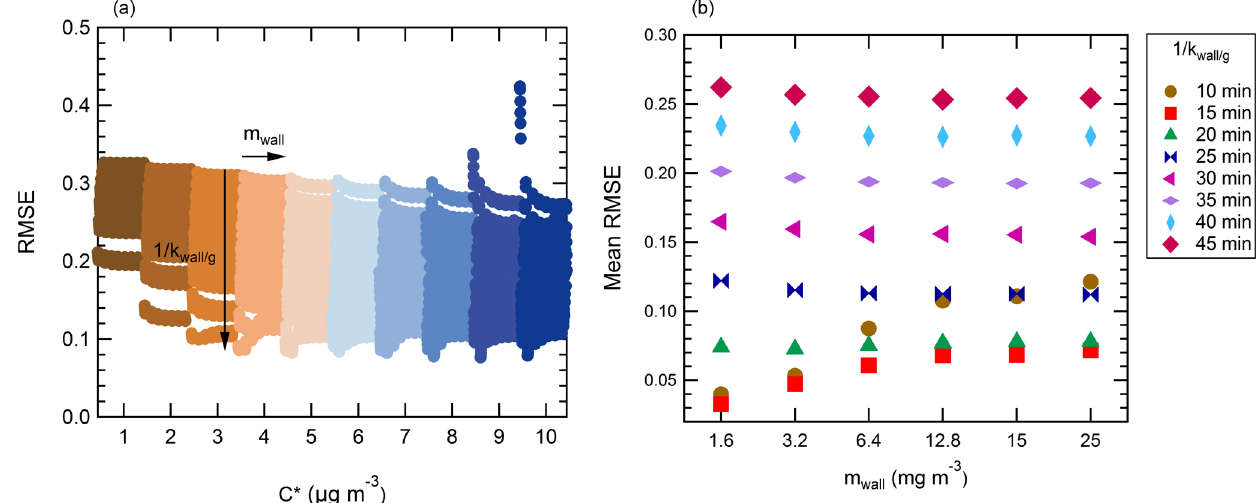
Figure 5. Influence of the different conditions (tested over a fine grid) on the performance (RMSE) of the model. The accommodation coefficient is set at 0.1. (a) Illustration of the influence of the saturation mass concentration C ∗ highlighted in a specific color. (b) Illustration of the average influence of the loss rate constant of the vapors k wall / g and equivalent organic mass concentration of the wall m wall on the performance of the model (average over the whole range of C ∗